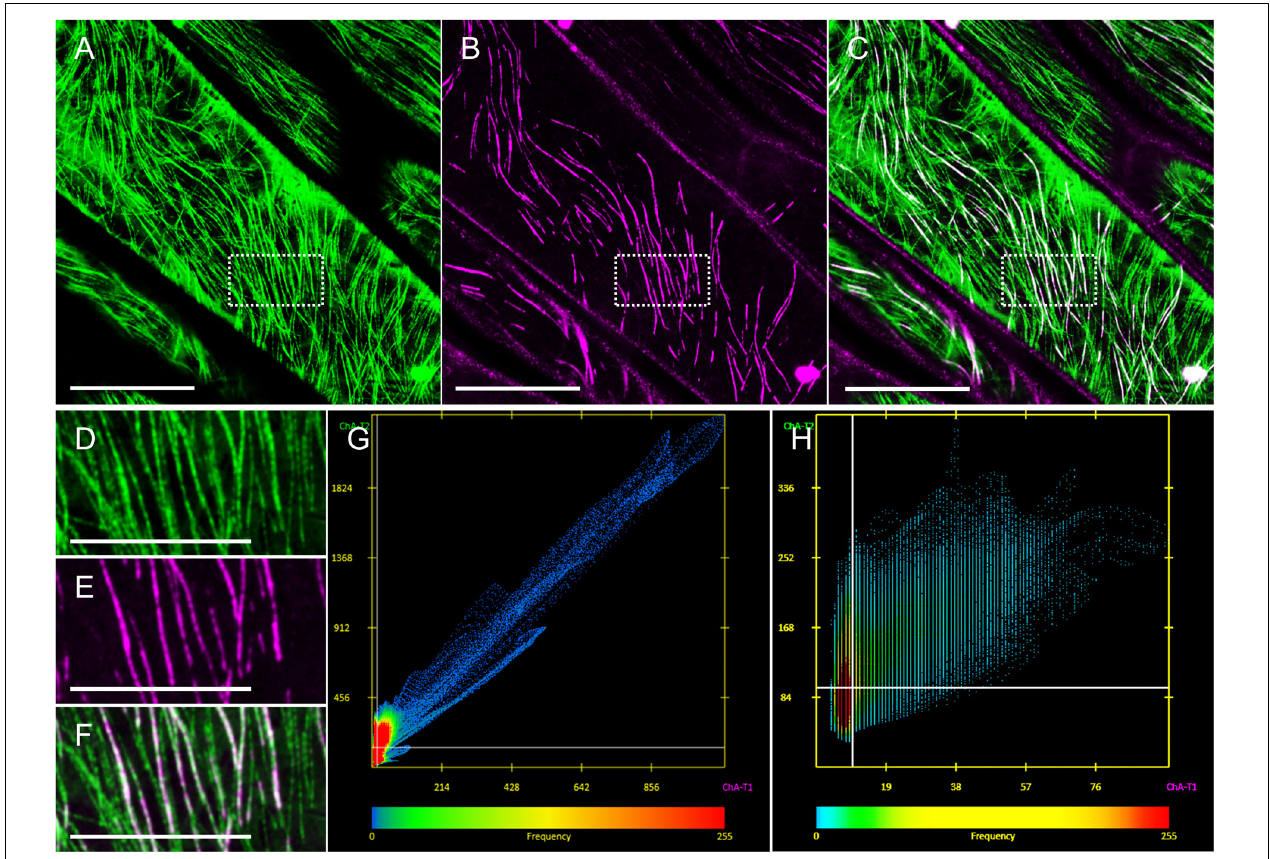
FIGURE 4 | Demonstration and analysis of MAP65-2 colocalization with cortical microtubules. Hypocotyl epidermal cells of stably transformed seedlings expressing both tagRFP-MAP65-2 and TUA6-GFP as visualized by ACLSM (objective 63 × /1.40 NA). (A–C) Overview of TUA6-GFP labeled microtubules (A) , tagRFP-MAP65-2 (B) , and their overlay (C) . (D–F) Magnified views of the boxed area of (A–C) showing again TUA6-GFP tagged microtubules (D) , tagRFP-MAP65-2 (E) and the resulting merged image (F) . (G,H) Scatterplots showing spatial correlation of green vs. red pixels for the entire field of view shown in C (G) or corresponding to the rectangular ROI (boxed area of C; H ). Scale bars = 10 µ m, (A–C) ; 5 µ m, (D–F)